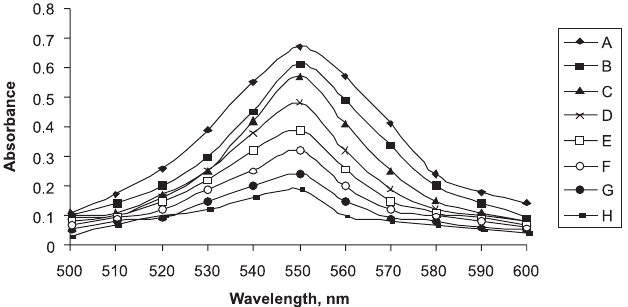
FIGURE 4 - Method A: Effect of SMT concentration on the absorbance of 3.164 x 10 -4 mol/L KMnO D.5.89; E.8.83; F.11.78; G.14.72 and H.17.67 x 10 -5 mol/L SMT ).